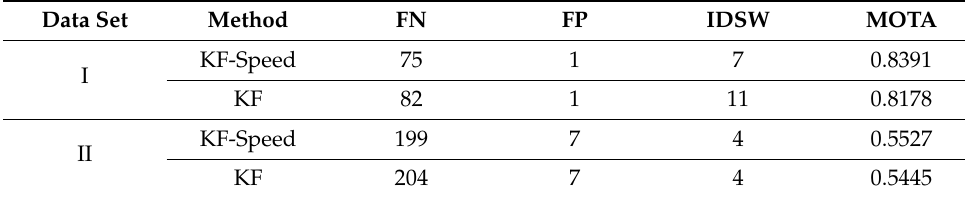
Table 8. Quality of Kalman filter tracking with and without speed information.